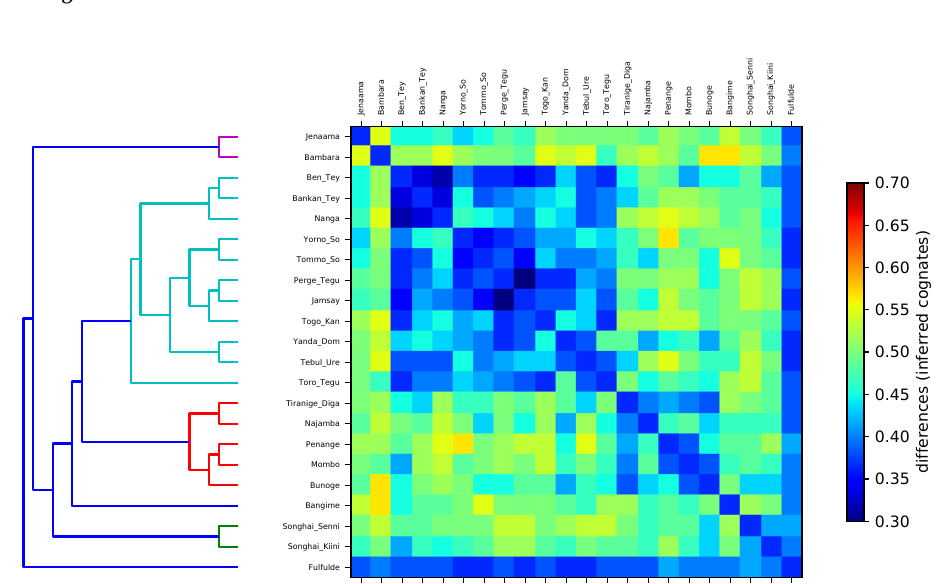
Figure 5: Comparing the discrepancies between cognate percentages inferred by LexStat‑Infomap and SCA. If no difference is encountered, we set the value in the heat‑ map to 0.5. If the proportions differ, we (cid:976)irst subtract the LexStat‑Infomap value from the SCA value and then add this value to our baseline of 0.5. As a result, comparing one language with itself will always yield the baseline, and values larger than 0.5 indicate to which degree SCA infers more cognates for the respective language pair, while val‑ ues less than 0.5 indicate that SCA infers less cognates. We suspect that those cases in which SCA infers a larger number of more cognates point to recent borrowings between the